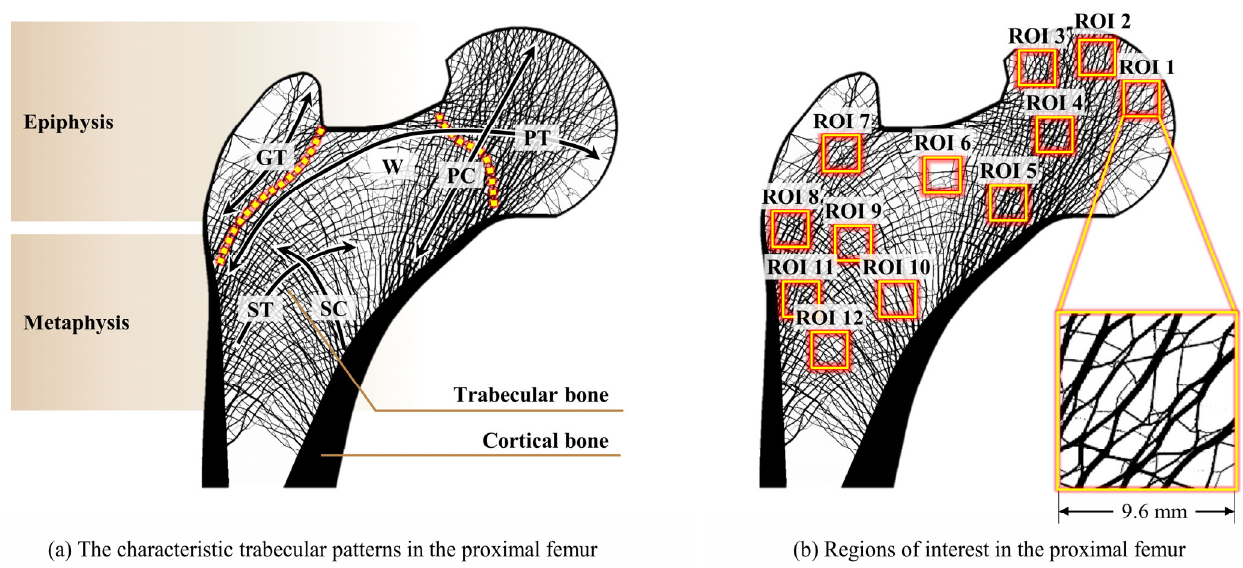
Figure 3. Characteristic trabecular patterns and 12 ROIs in the human proximal femur. ( a ) Important anisotropic loading groups: GT: the greater trochanter group; PC: principal compressive group; PT: principal tensile group; SC: secondary compressive group; ST: secondary tensile group; and W: Ward’s triangle; and ( b ) sizes and locations of the selected ROIs considering the characteristic pat ‐ terns.